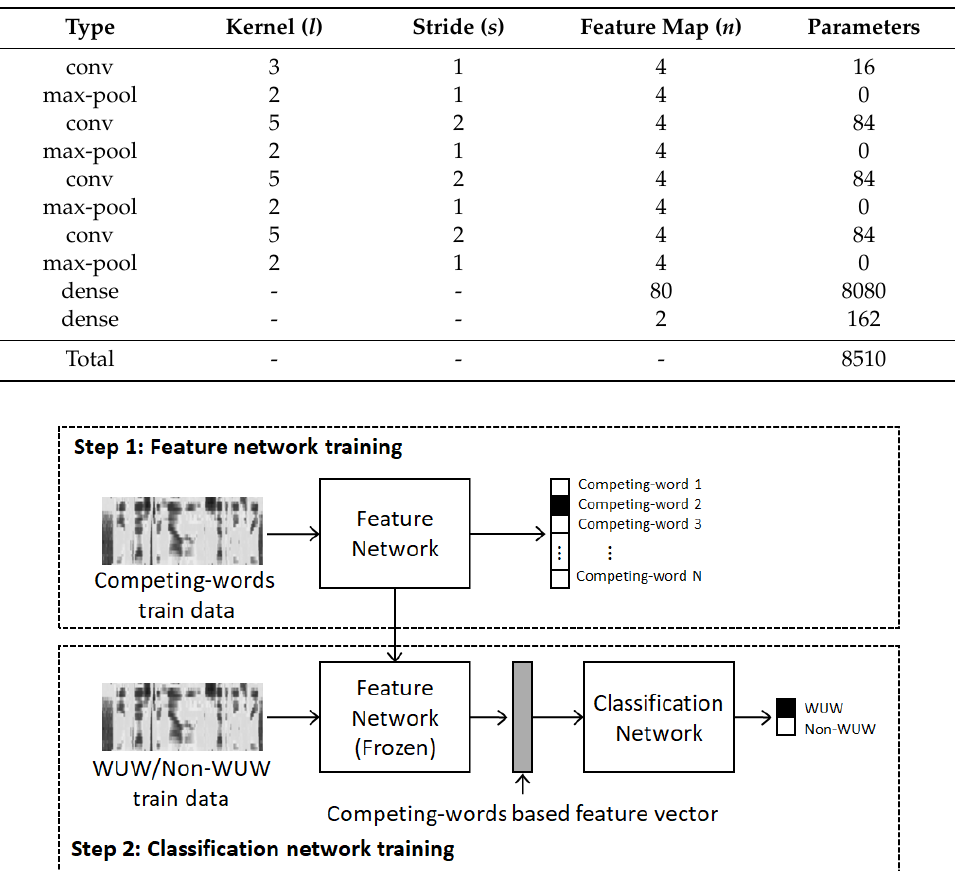
Table 2. Parameters used for the classification network of the proposed system.